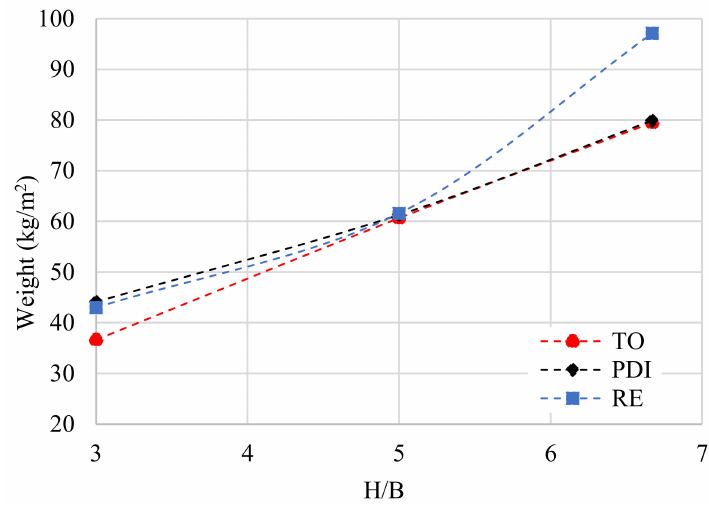
Figure 14. Comparison among the analysed patterns: unit steel